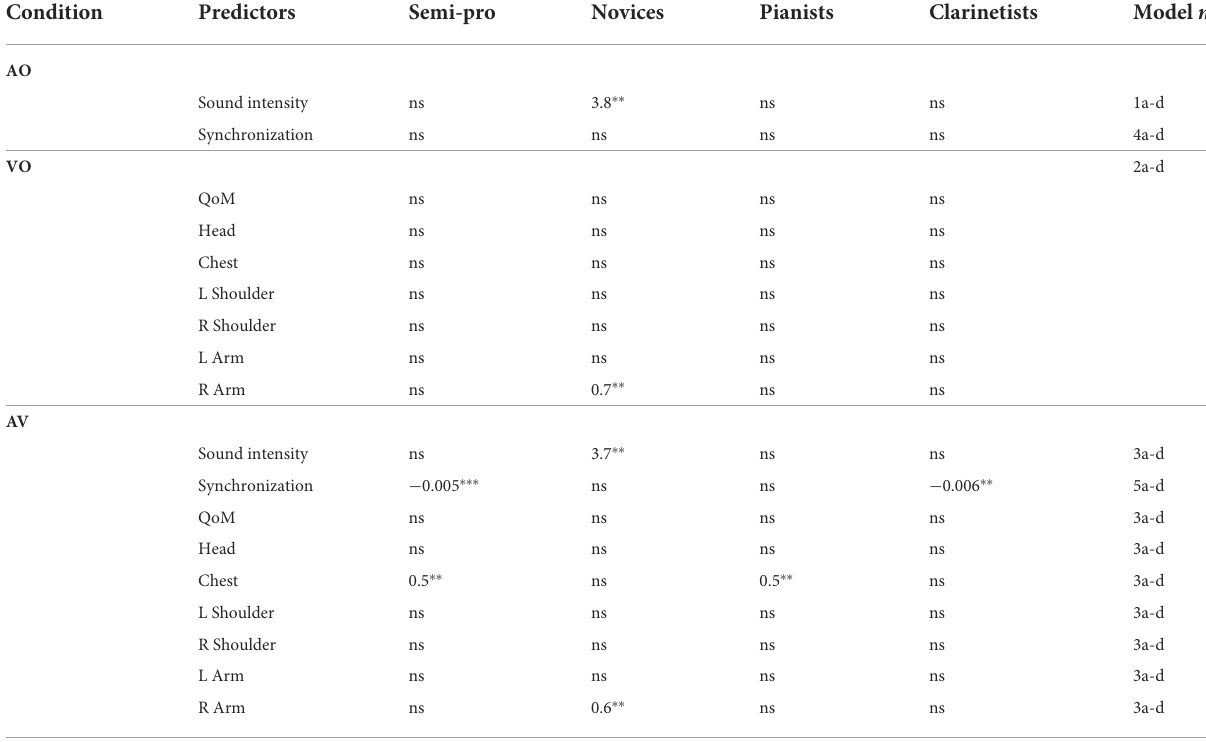
TABLE 4 Overview of the generalized mixed models displaying β coefficients and significance measuring the relationship between performance cues (i.e., auditory and visual cues) and togetherness ratings for each modality (i.e., AO, audio only; VO, video only; and AV, audio+video) and each participant group (i.e., semi-professional musicians, novices, pianists, clarinetists, and all participants).